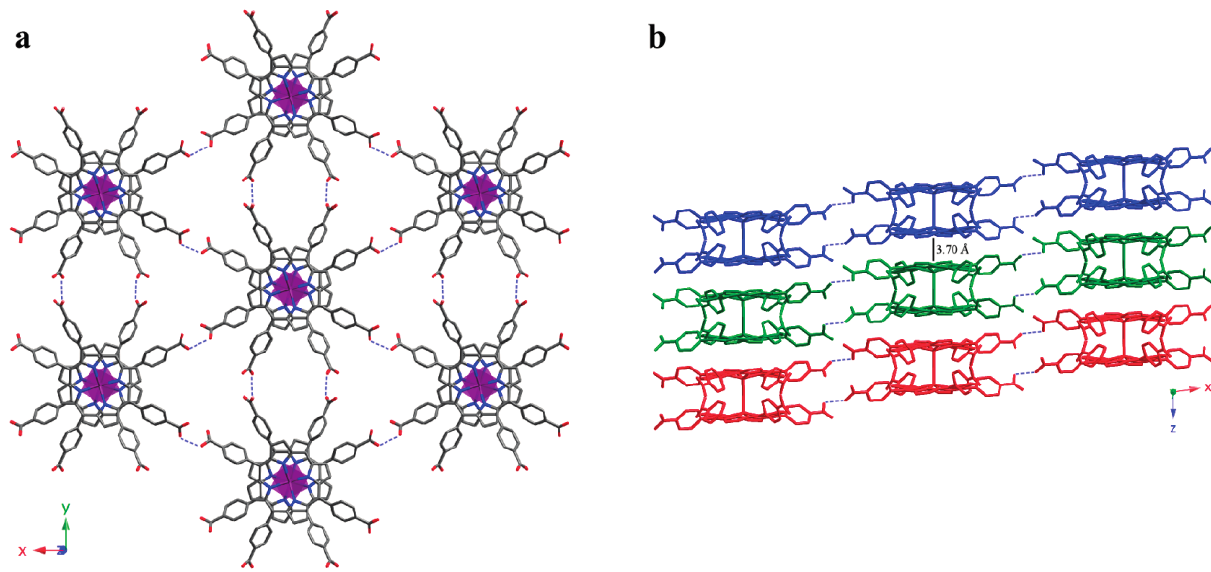
Figure 4. ( a ) View of the H-bonded 2D layer for compound 2 ; ( b ) Stacking of the 2D layers for compound 2 , where each layer is shown in a different colour. Intralayer H-bonds are shown as dashed lines. (Fe: purple, C: grey, N: dark blue, O: red). H atoms have been omitted for